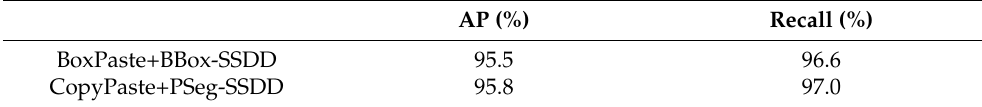
Table 3. Performance comparison between BoxPaste+BBox-SSDD and CopyPaste+PSeg-SSDD.